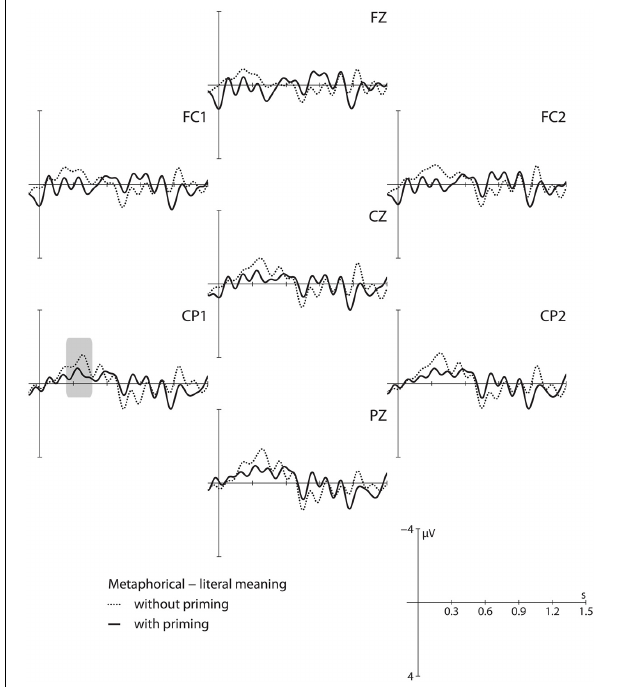
FIGURE 4 | Difference wave plots for Experiment 1. Difference waves for metaphorical minus literal condition without (dashed line) and with (solid line) priming. The vertical bar marks the word recognition point of the target. The critical time-window is shaded in